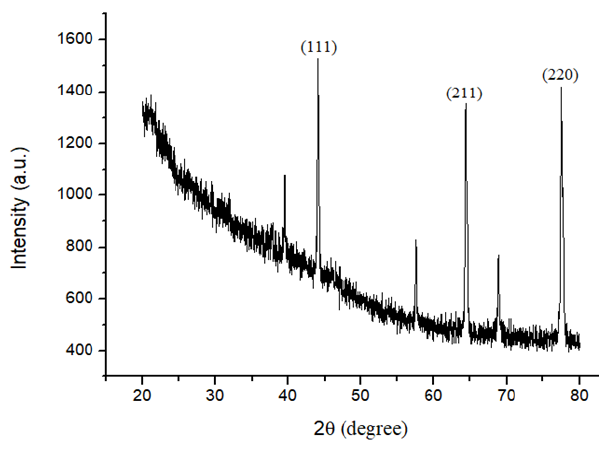
Fig. 6. Diffractogram